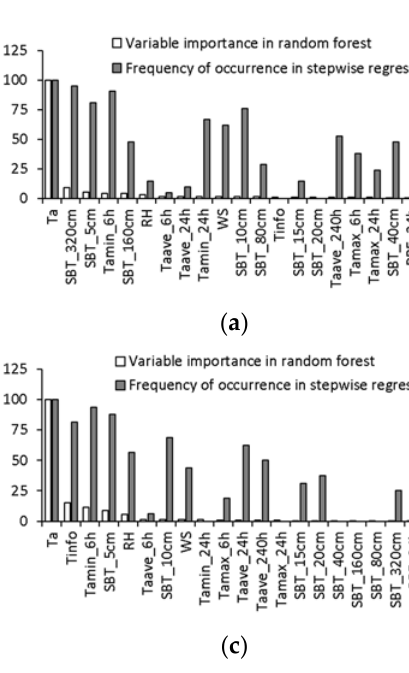
Figure 7. The importance of each factor in the random forest model (white bar) and the possibility of the occurrence of each factor in step wise regression model (gray bar) at ( a ) road surface station 1, ( b ) road surface station 2, ( c ) bridge deck station 1, ( d ) bridge deck station 2.